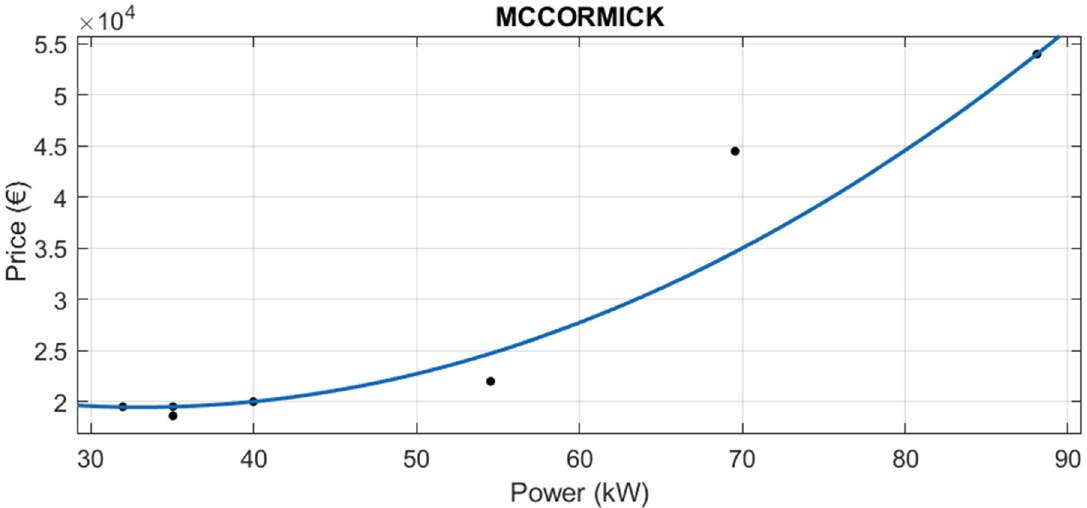
Figure 10. Price vs. power for McCormick new tractors.